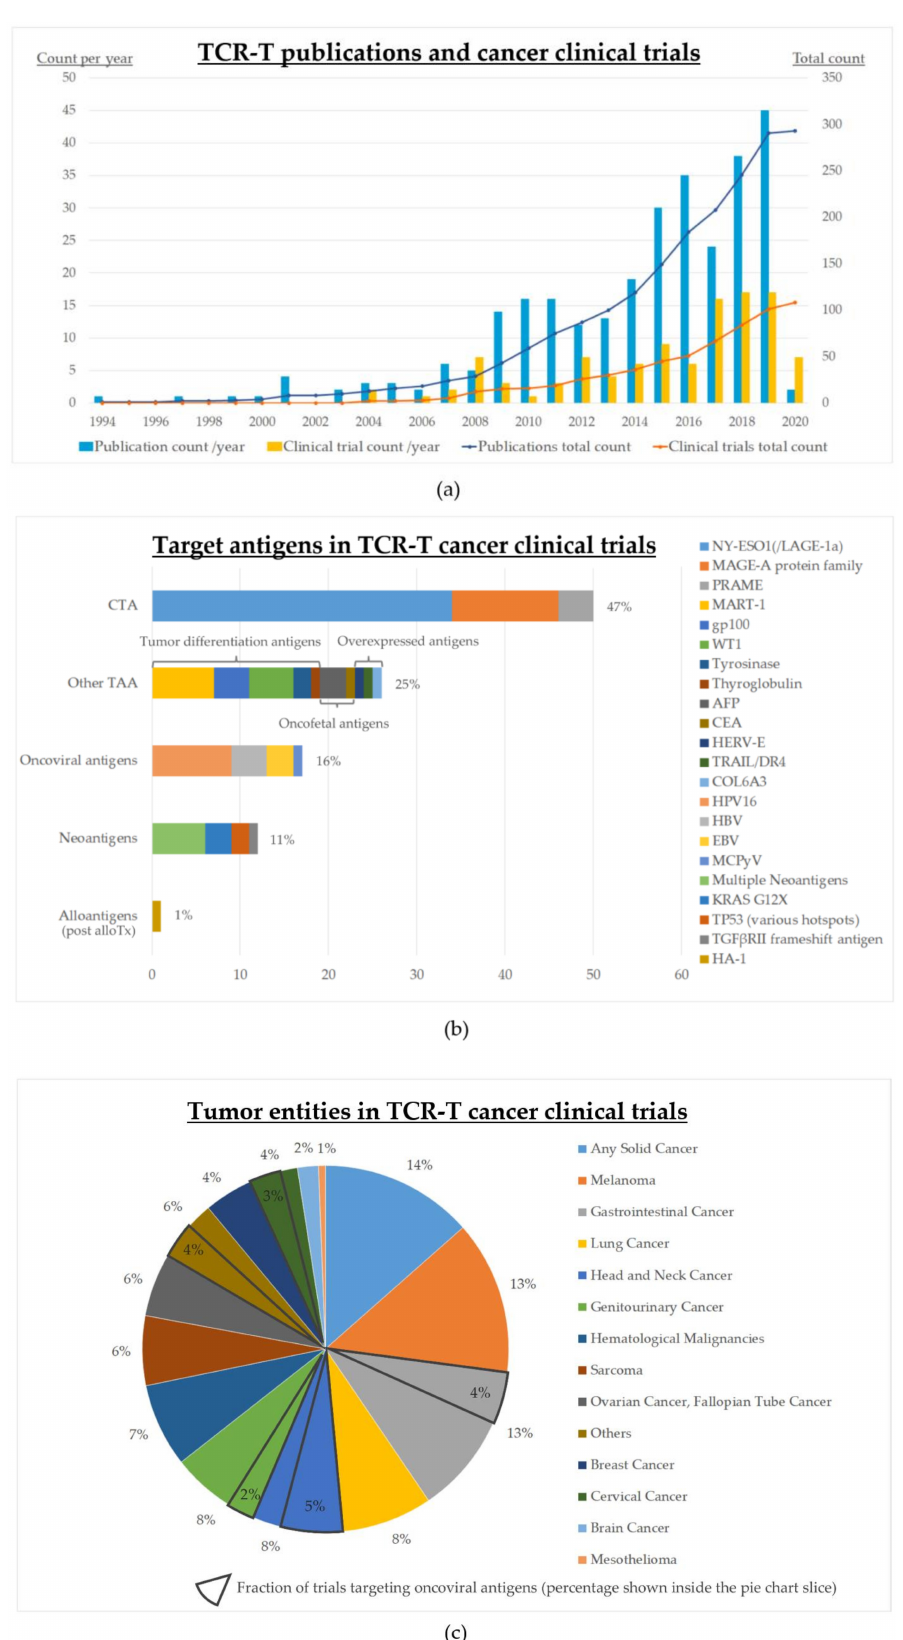
Figure 2. Status quo of clinical development for cancer TCR-T therapies as of June 2020: ( a ) numbers of clinical trials ( n = 104) and publications ( n = 293); ( b ) target antigens in the various clinical